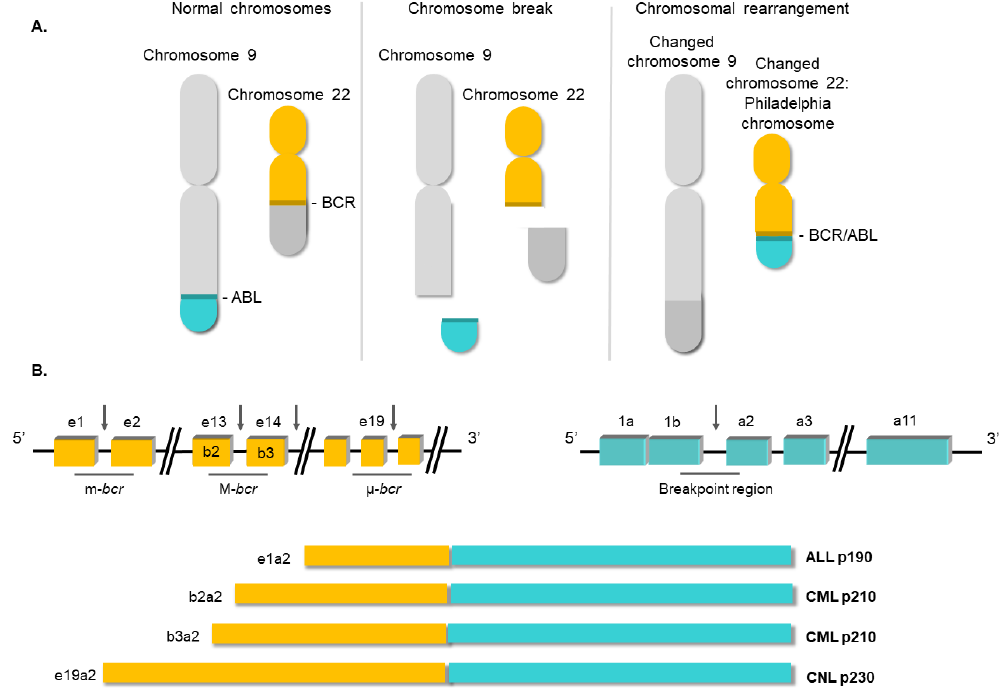
Figure 2. Structure of the BCR/ABL1 oncogene. ( A ) Schematic representation of the t(9;22) (q34;q11) translocation triggering the Philadelphia chromosome. ( B ) Breakpoint locations between BCR and ABL1 genes. Different fusion protein combinations yield different outcomes.